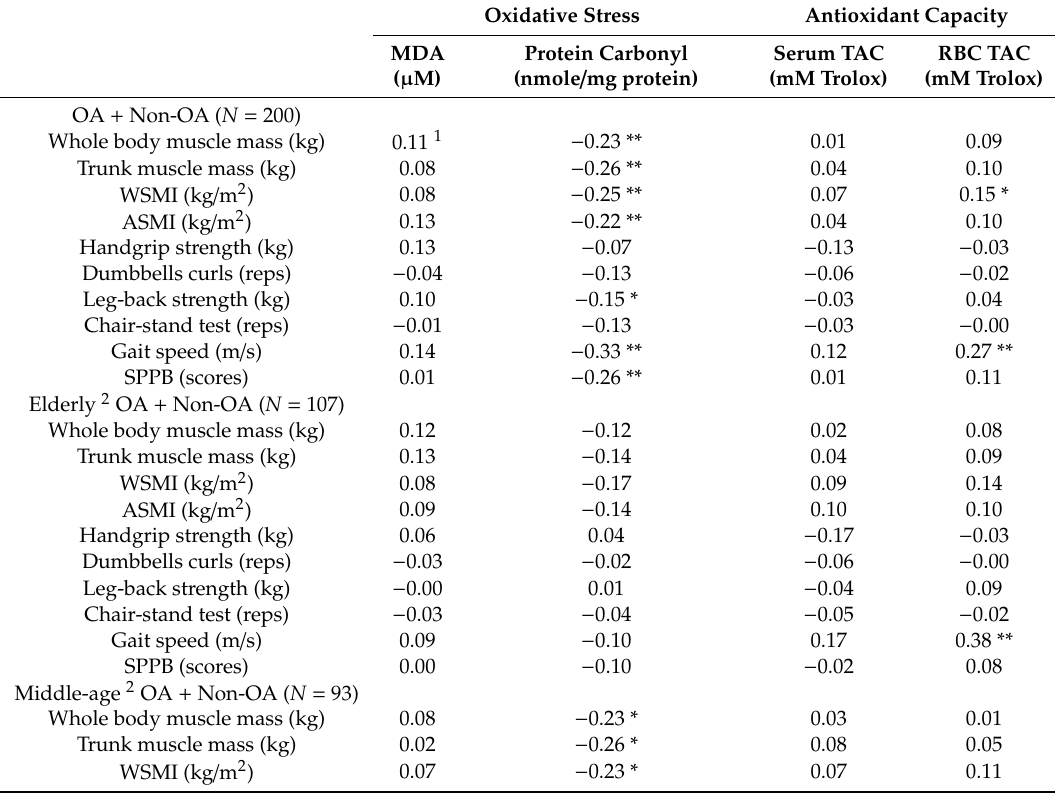
Table 4. Correlations between oxidative stress, antioxidant capacity, muscle mass, muscle strength, and muscle endurance of the